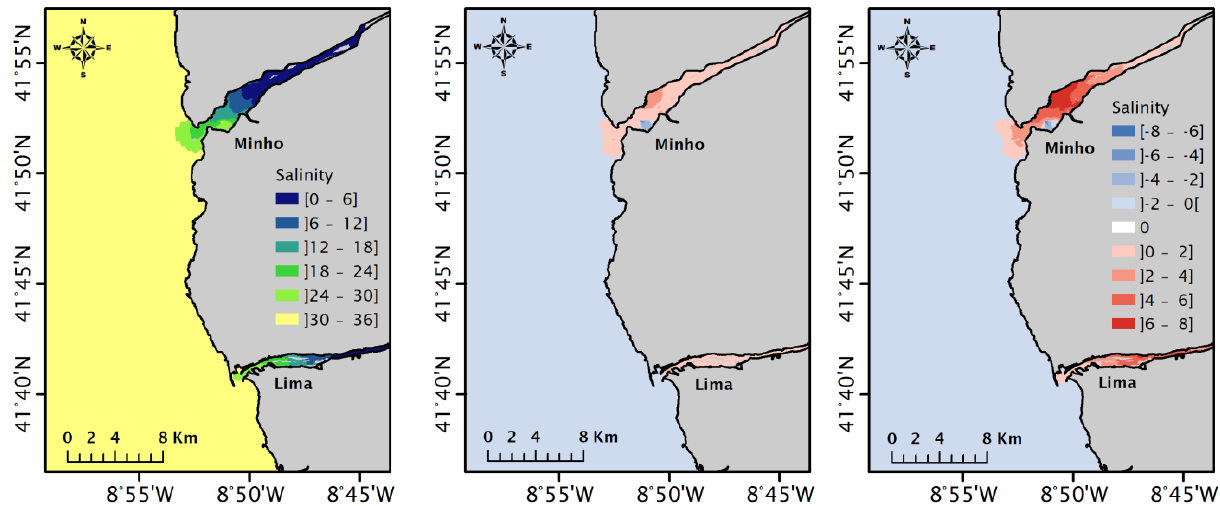
Figure 9. Estuarine plume during summer conditions. The left map represents the average saline distribution for the Present scenario, and the centre and right maps the differences between the RCP 4.5/RCP 8.5 scenarios and the Present scenario, respectively.